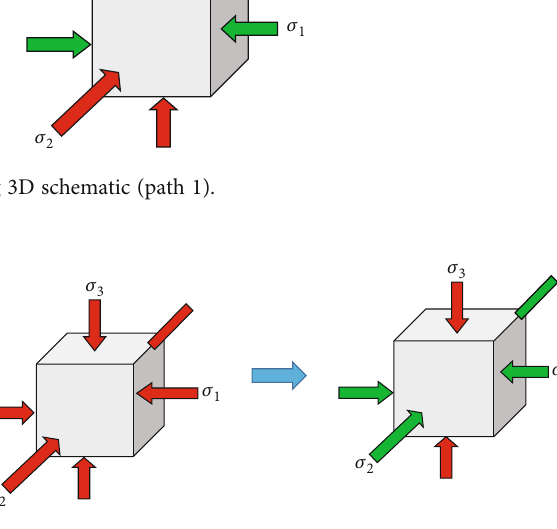
Figure 3: Loading and unloading 3D schematic (path